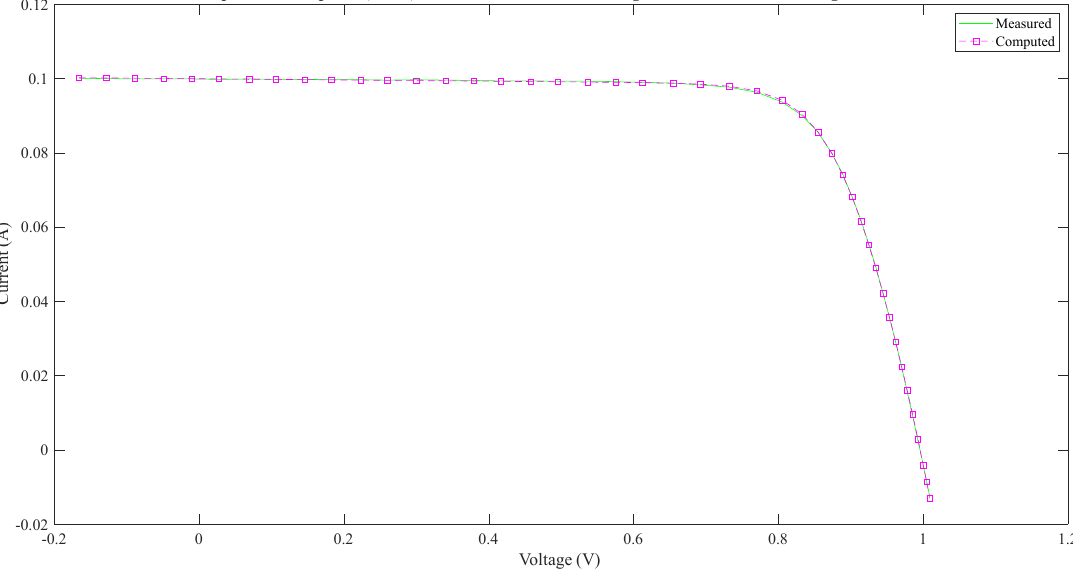
Figure 9. The current-voltage characteristics of PVM 752 GaAs photovoltaic panel for the single diode (SDM).